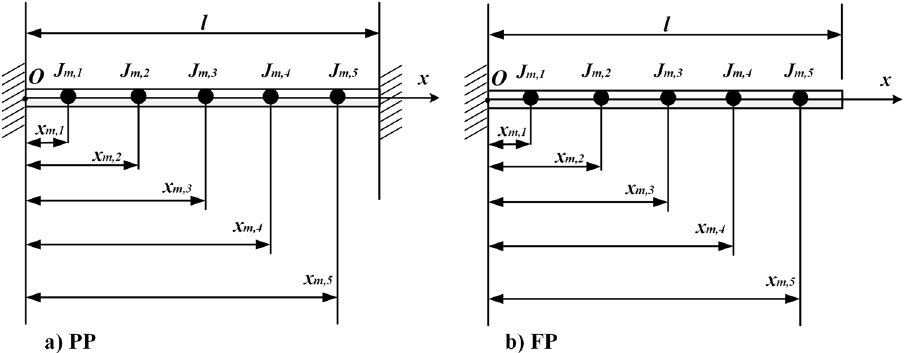
Figure 5. The shaft carrying five rotary inertias.